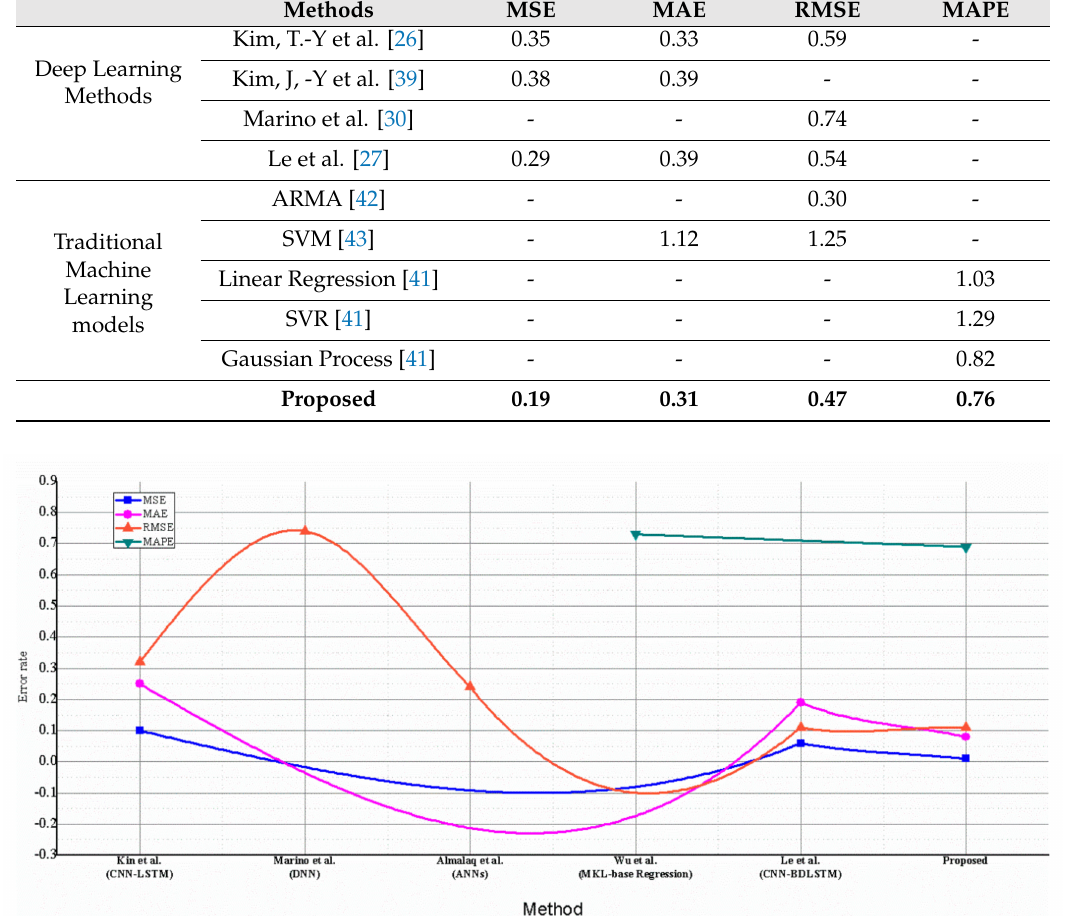
Figure 12. Comparative analysis of the proposed hybrid CNN with LSTM-AE model with the methods developed by Kim et al. [26], Marino et al. [30], Almalaq et al. [40], Wu et al. [41] and Le et al. [27].